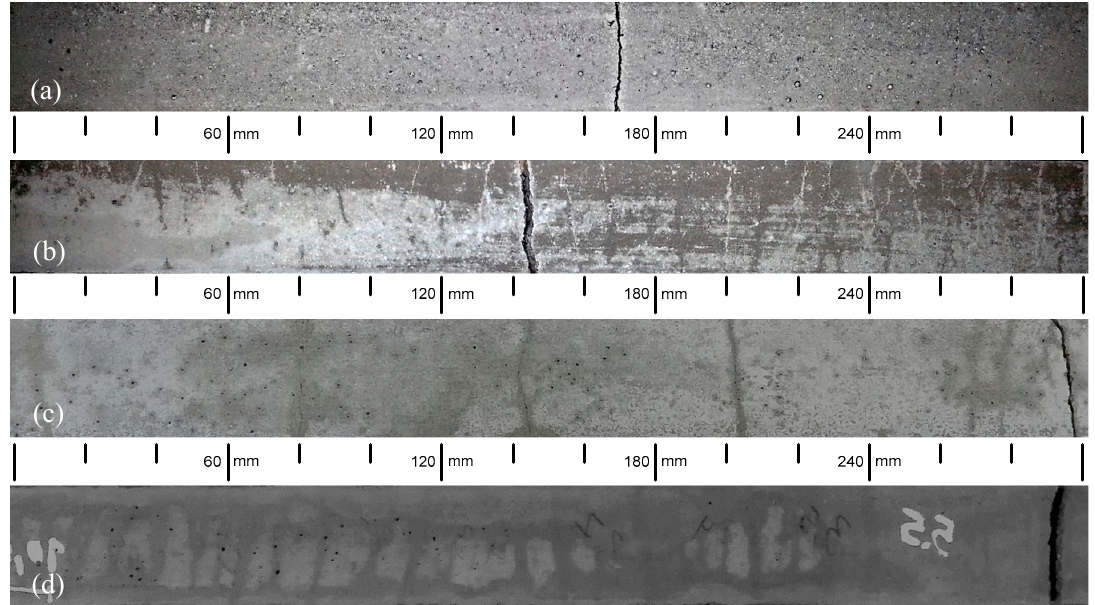
Figure 9. View of the ties after tensile testing: ( a ) A35, ( b ) A50, ( c ) A40, ( d ) A60.